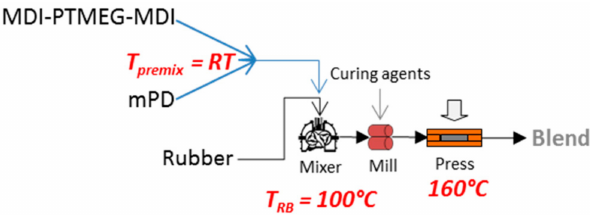
Figure 1. Reactive blending process to prepare rubber/PUU blends. The structures of PTMEG-MDI based isocyanate-terminated prepolymer and m-phenylene diamine are shown